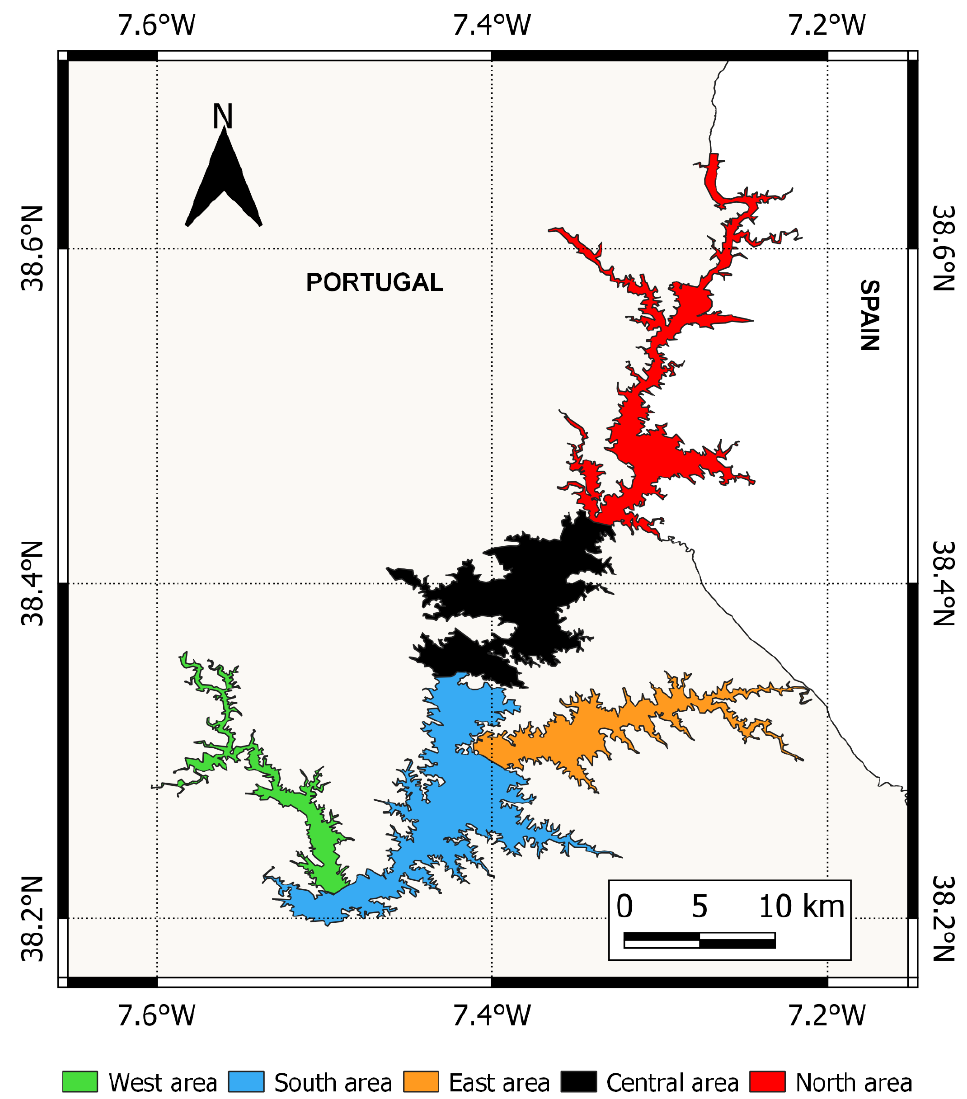
Figure 1. Alqueva reservoir divided into five areas for water quality analysis. Table 1. Periods considered for each dataset used.